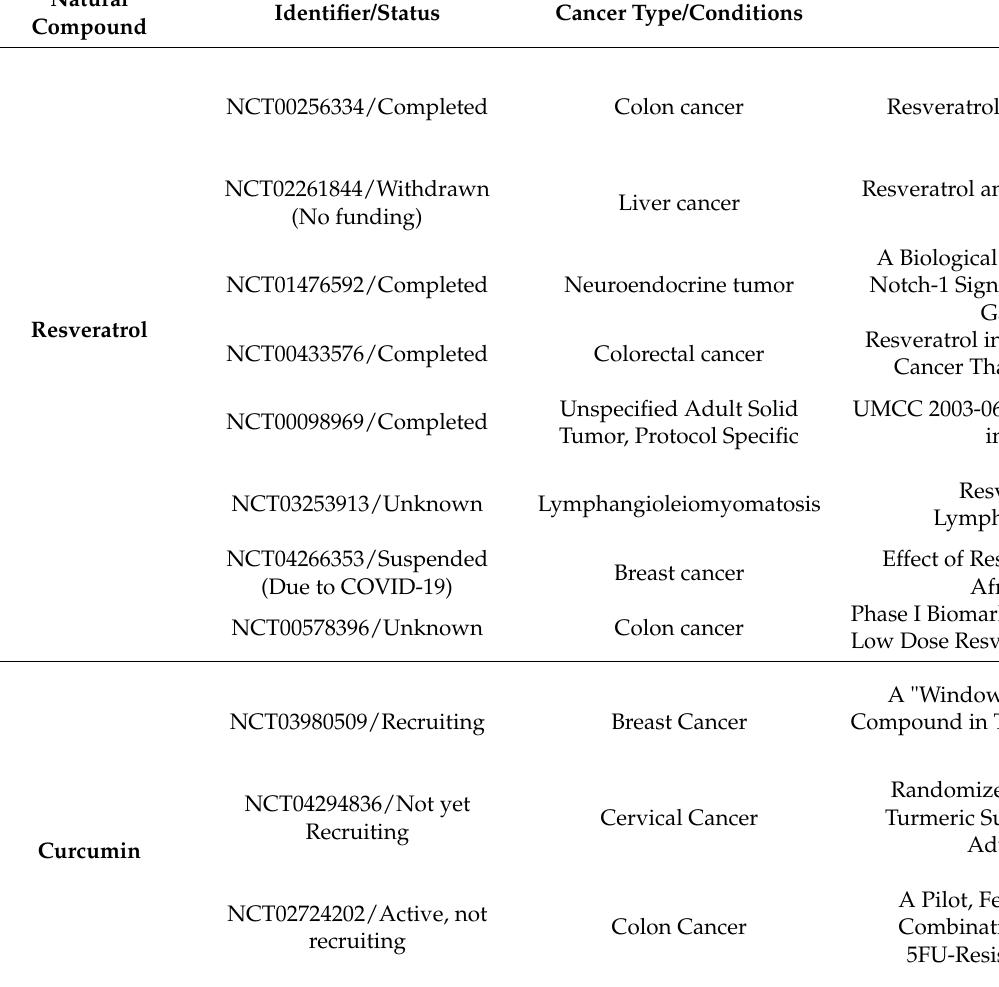
Table 3. Relevant examples of natural compounds found in clinical trials (according to data from US National Library of Medicine — ClinicalTrials.gov).